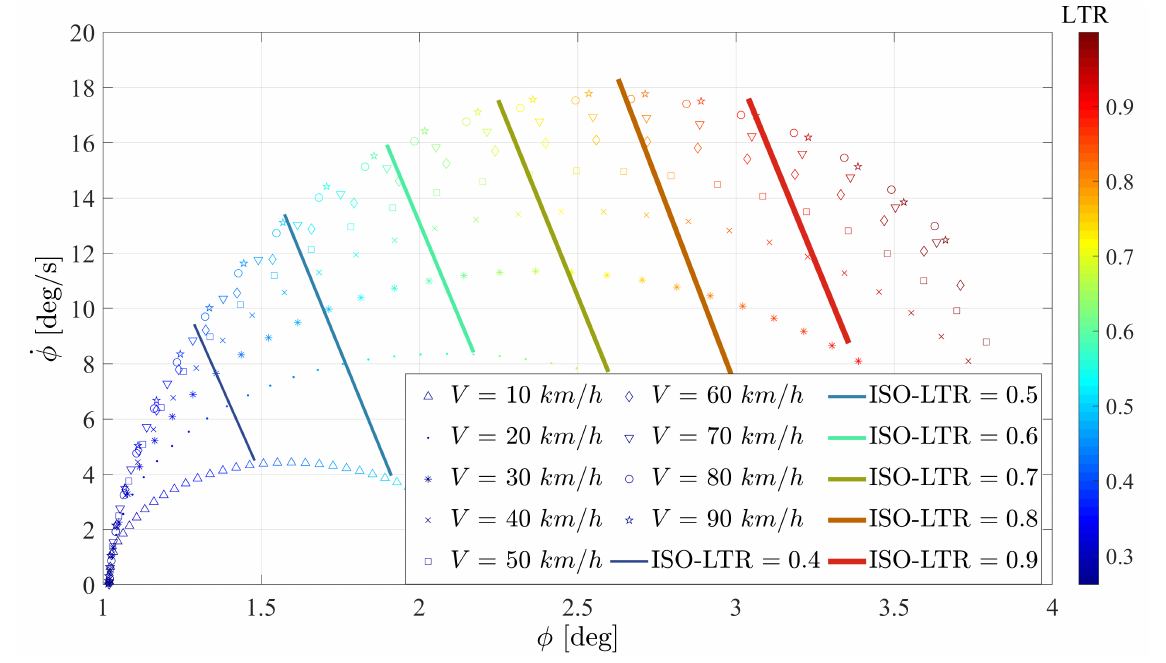
Figure 10. ISO-LTR characteristics obtained during a fast ramp steering manoeuvre on a 10deg banked road at different